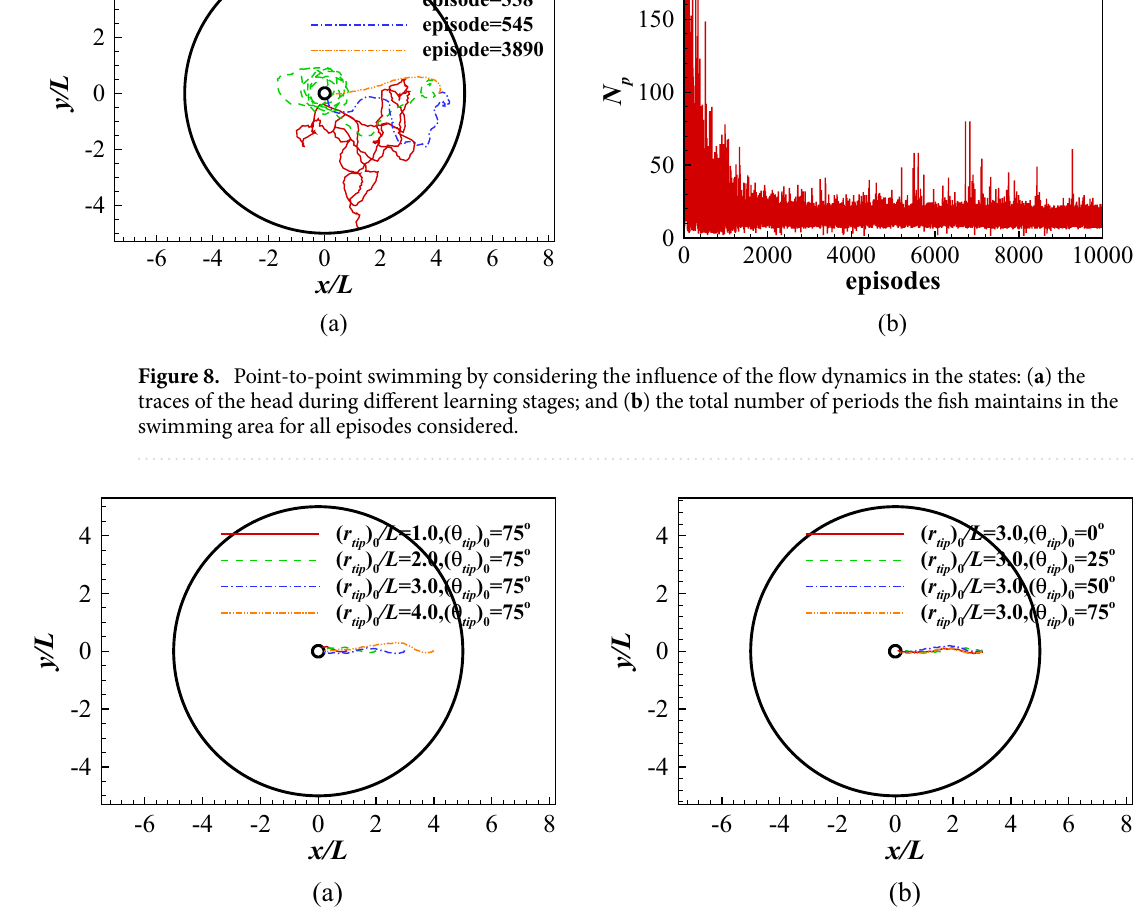
Figure 9. Point-to-point swimming: ( a ) the traces of the head for different initial distance ( r tip ) 0 ; and ( b ) the traces of the head for different initial orientations (θ tip ) 0